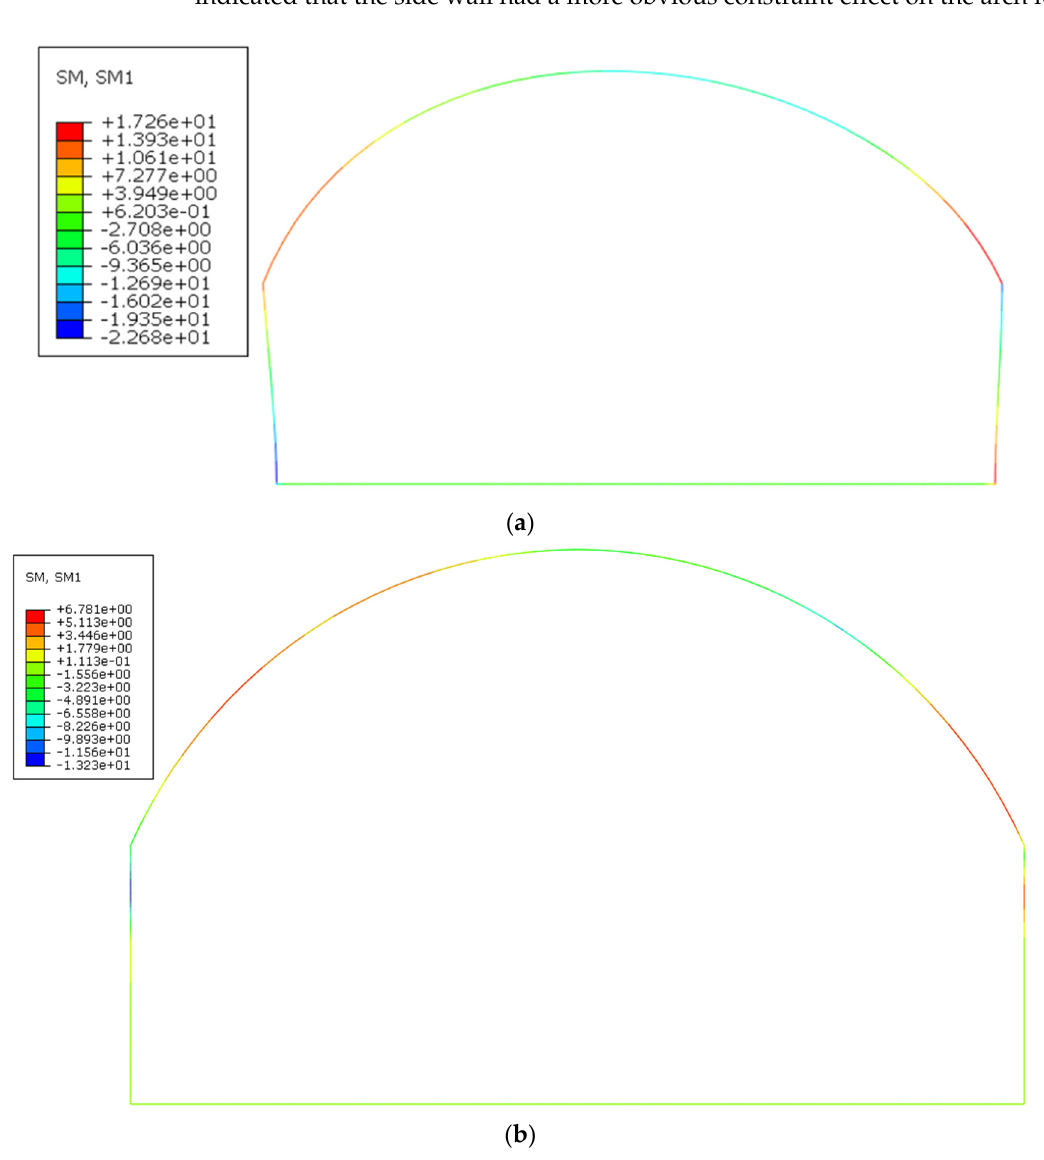
Figure 16. Simulation results of bending moments. ( a ) No side wall; ( b ) Side wall.